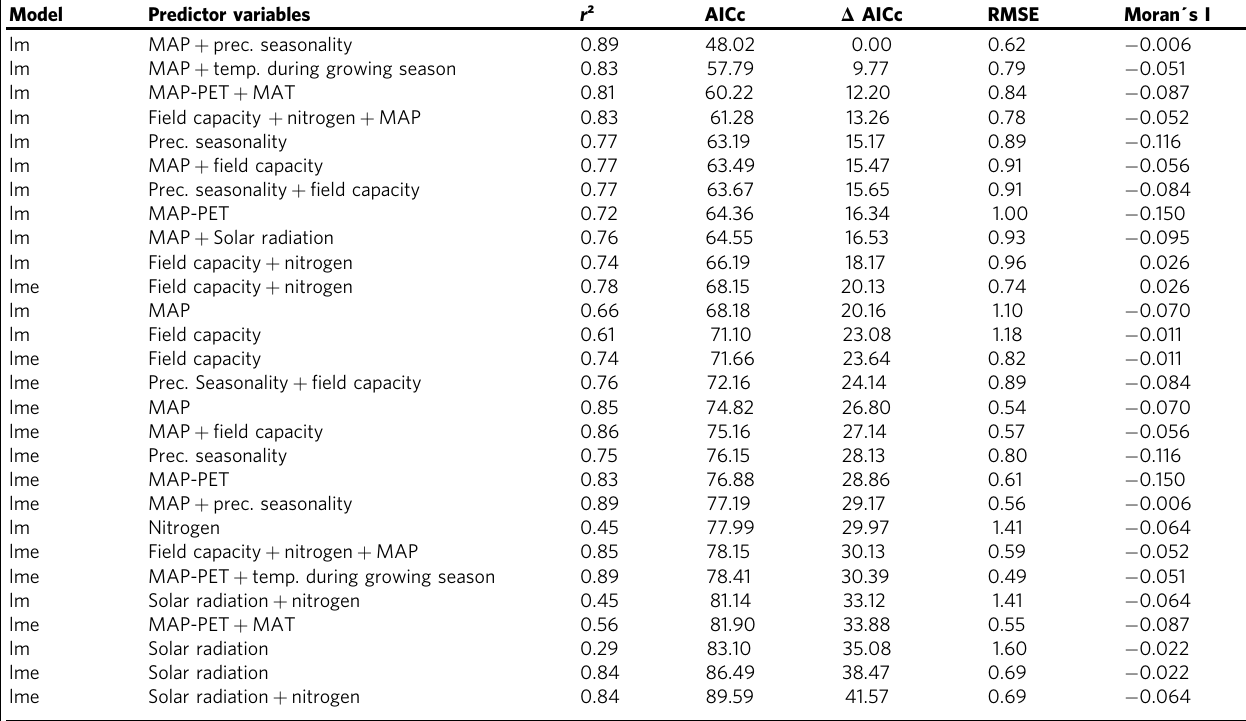
Table 1 Coef fi cient of determination ( R ²), Akaike Information Criterion (AIC c ), difference in AIC c value between the respective